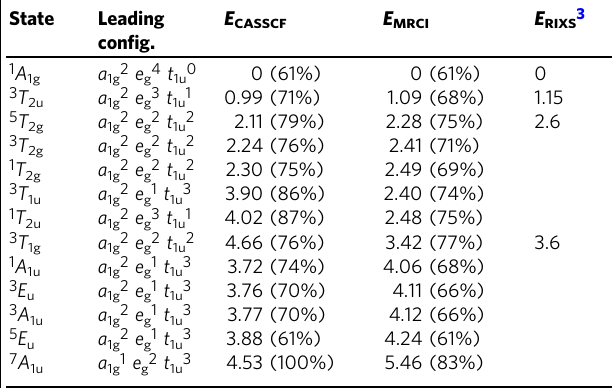
Fig. 2 Orbitals of the chosen complete active space with six electrons and six orbitals (CAS(6,6)). a Symmetry-adapted (O h point-group symmetry) orbitals for the B 6 2 − unit. b Site-centered symmetry-equivalent orbitals derived from the former (only two out of six are shown). Table 1 Excitation energies (eV) for a B 6 2 − octahedral block in CaB 6 (CAS(6,6) reference). State Leading con fi g.